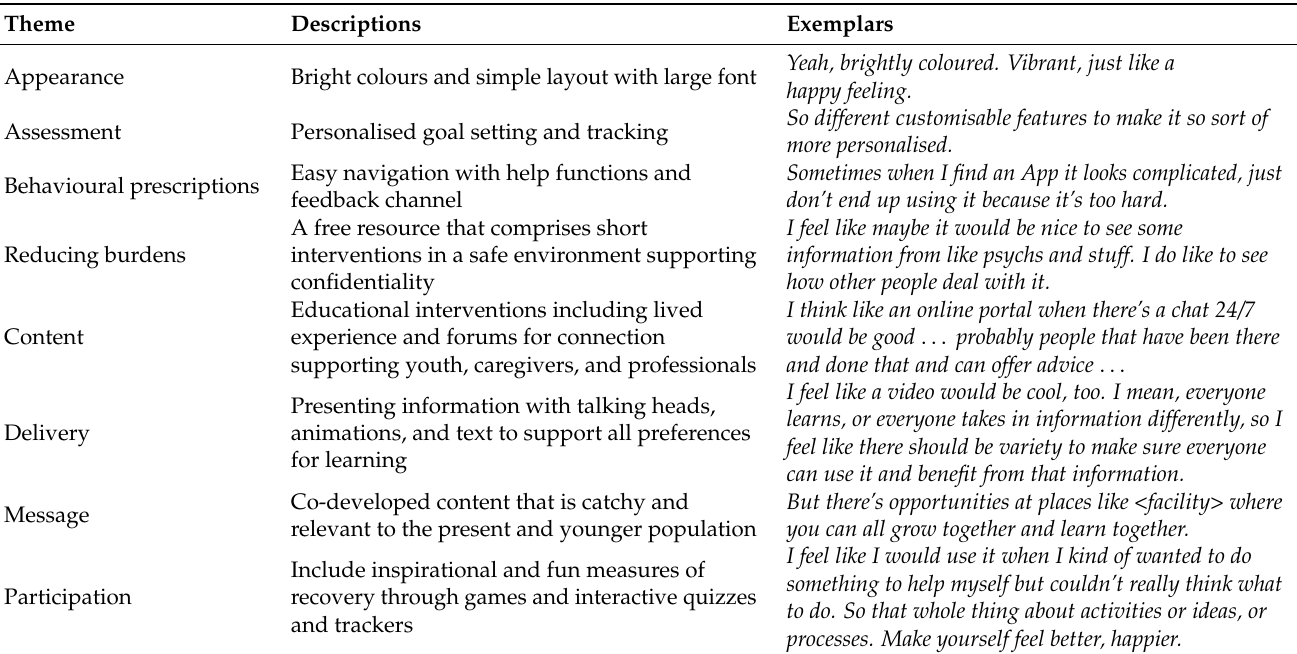
Table 10. Key elements of digital applications supporting youth recovery generic and